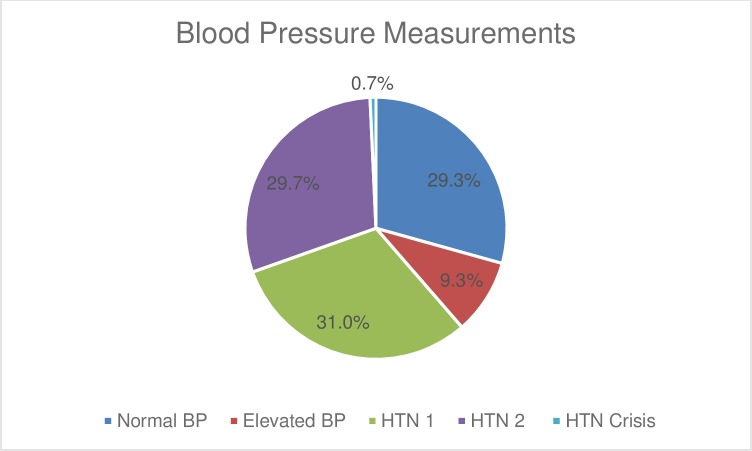
The distribution of blood pressure (BP) readings of the SARHC patients expressed in % of total measurements.Normal BP was a systolic blood pressure (SBP) < 120 mmHg and a diastolic blood pressure (DBP) < 80 mmHg; elevated BP was SBP 120–129 mmHg and DBP < 80 mmHg; Hypertension 1 (HTN 1) was SBP 130–139 mmHg or DBP 80–89 mmHg; Hypertension 2 (HTN 2) was SBP > 140 mmHg or DBP > 90 mmHg, and Hypertensive Crisis (HTN Crisis) was SBP > 180 mmHg or DBP > 120 mmHg.